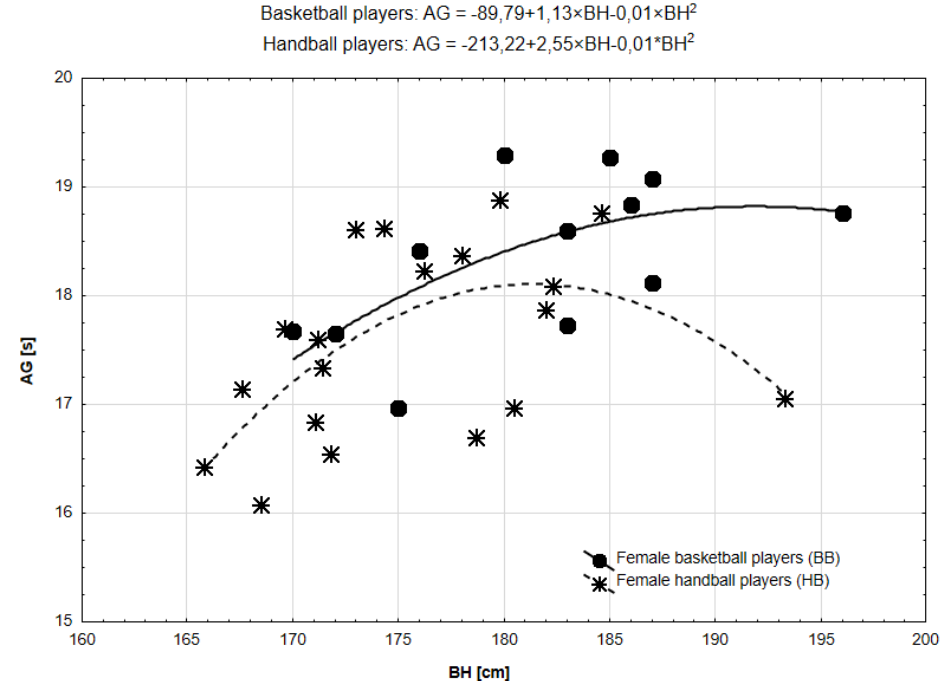
Figure 4. Functional forms of the relationships between BH and AG in BB and HB.